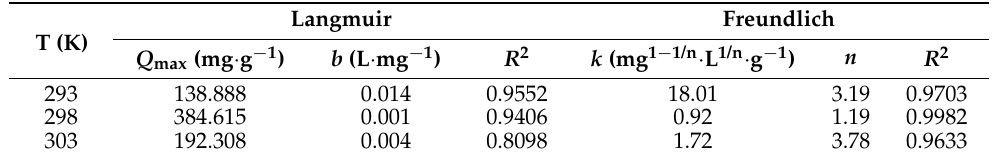
Table 3. The parameters for Langmuir and Freundlich models for Cu 2+ sorption onto GO(20)/cellulose(100) hydrogel.